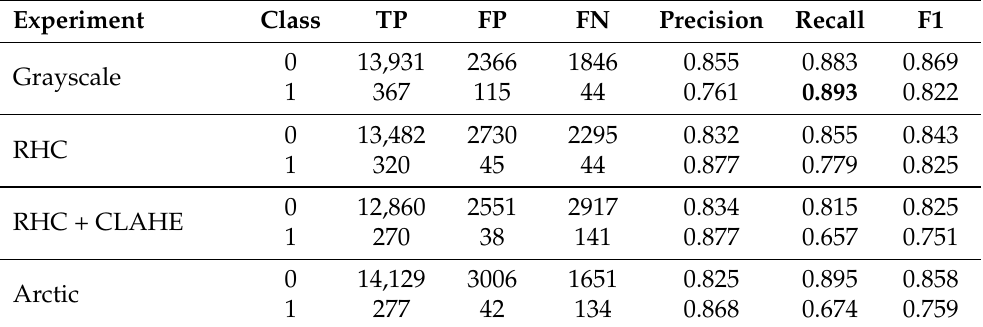
Table 3. Metrics for the first group of